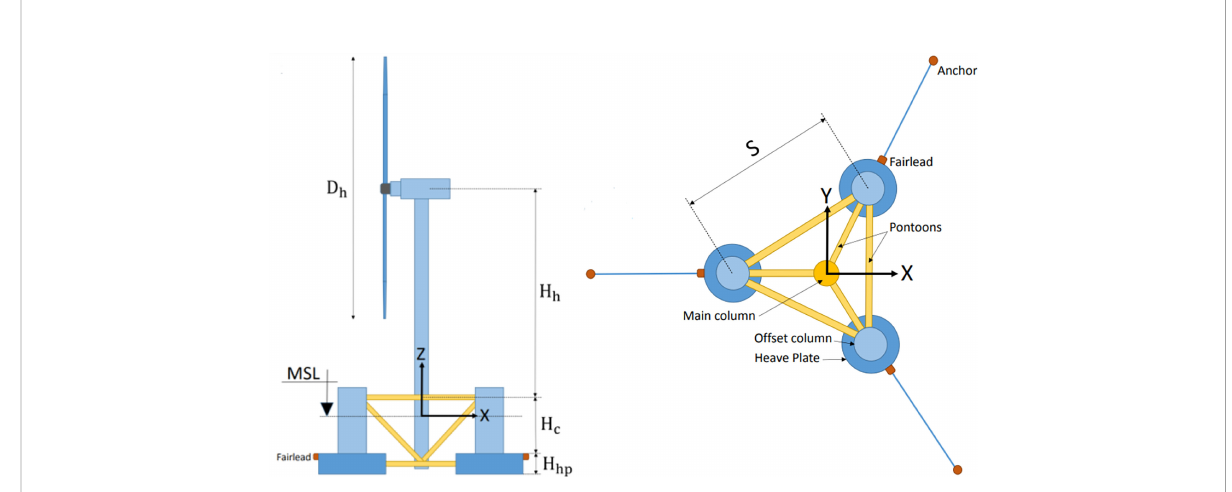
FIGURE 1 General schematic view of the DeepCwind semi-submersible FOWT. Left: Side view; Right: Top view (Head et al.,